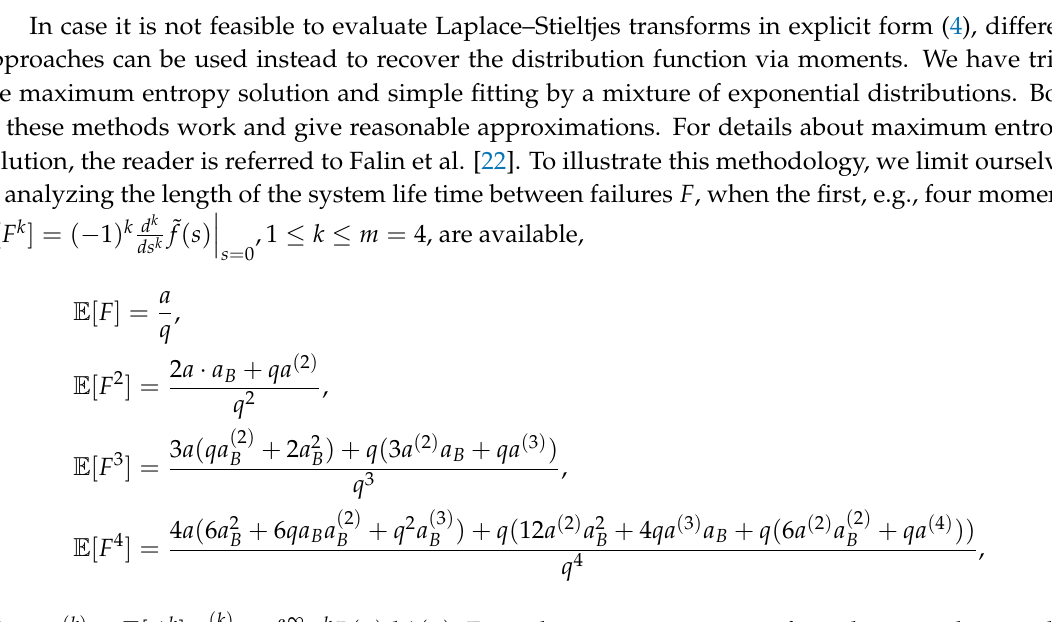
, M 1 ) and B ∼ PH ( η 1